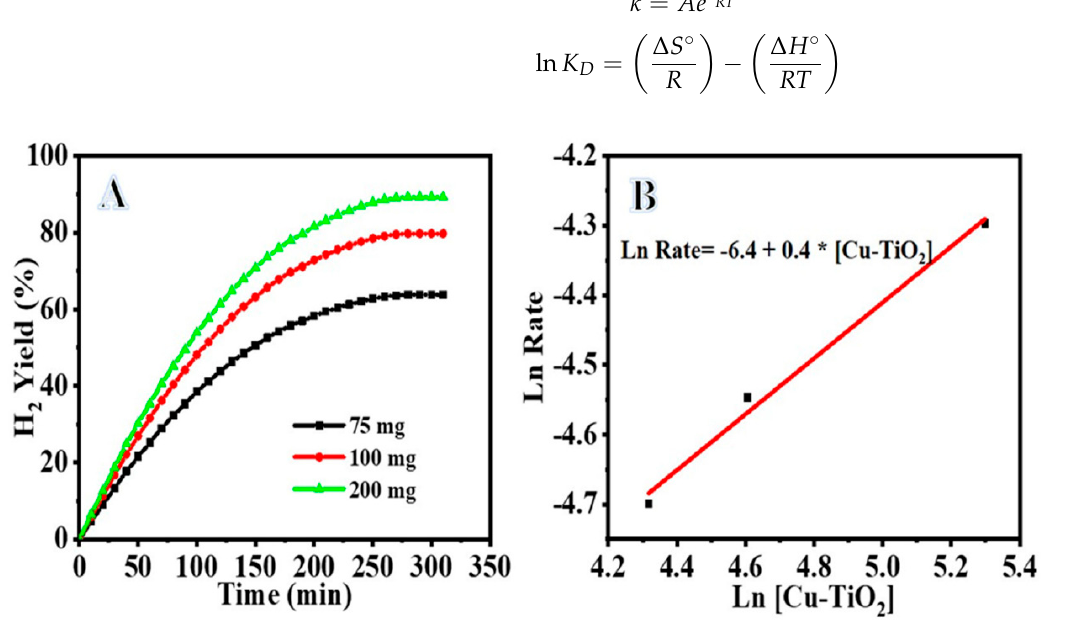
Figure 6. ( A ) Effect of Cu − TiO 2 amount on hydrogen generation from aqueous NaBH 4 ; ( B ) plot of logarithmic hydrogen generation rate vs. Cu − TiO 2 amount.